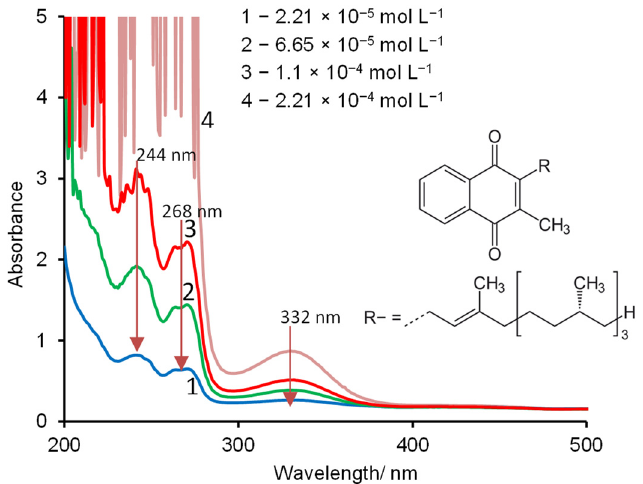
Figure 1. The UV-Vis spectra recorded in aqueous environment for different concentrations of vitamin K.